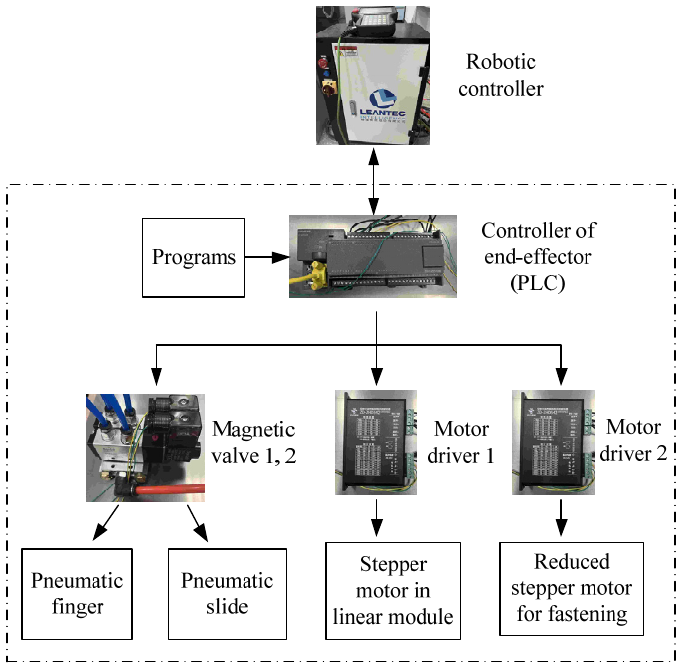
Figure 12. Control system of experimental platform.